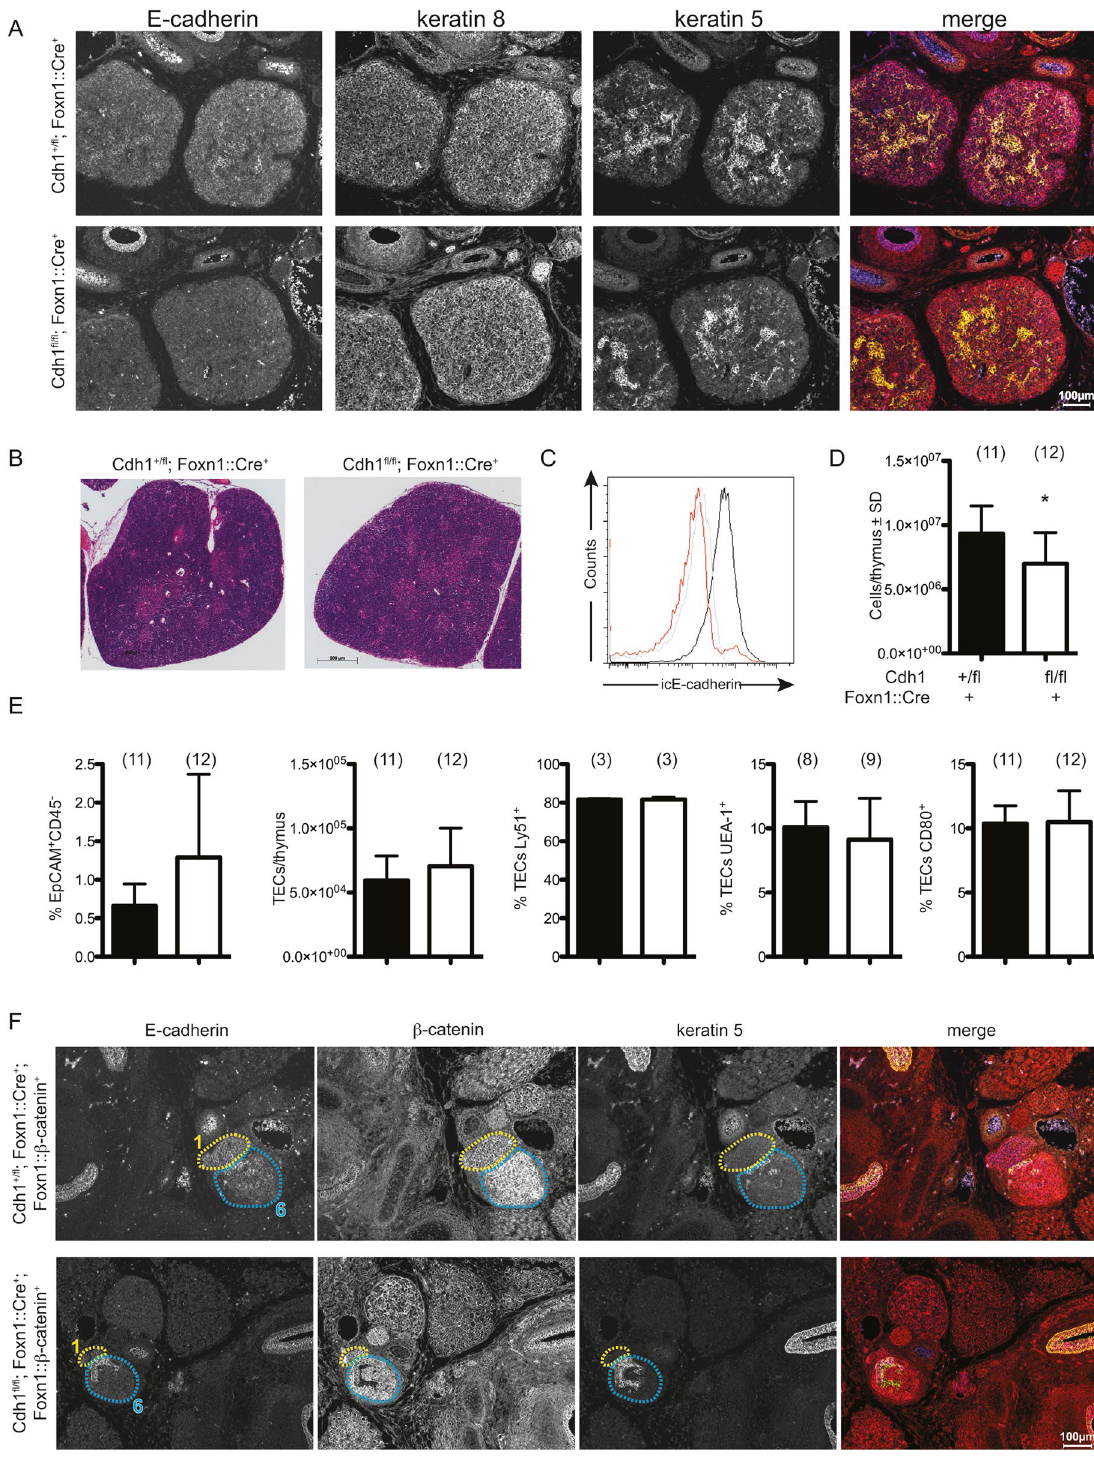
Figure 4. E-cadherin is not required for normal thymus development. ( A ) Immunofluorescence analyses of thymus sections of E15.5 control (top row) or E-cadherin deficient (bottom row) embryos stained with antibodies against the indicated antigens. ( B – E ) Analysis of thymi from newborn control and E-cadherin- deficient mice. ( B ) H&E staining. ( C ) Staining for intracellular E-cadherin in CD45 − EpCAM + TECs from control (black tracing) or E-cadherin deficient (red tracing) mice; isotype control staining (grey tracing). ( D ) Total cell numbers in the thymus. ( E ) Proportion and absolute numbers of total TECs, proportions of Ly51 + , UEA-1 + and CD80 + TECs in control (black bars) and E-cadherin-deficient (open bars) thymi. In D and E, data are depicted as mean ± SD. ( F ) Immunohistochemistry analyses of E15.5 E-cadherin-sufficient or -deficient Foxn1:: β -catenin-transgenic embryos with antibodies against the indicated